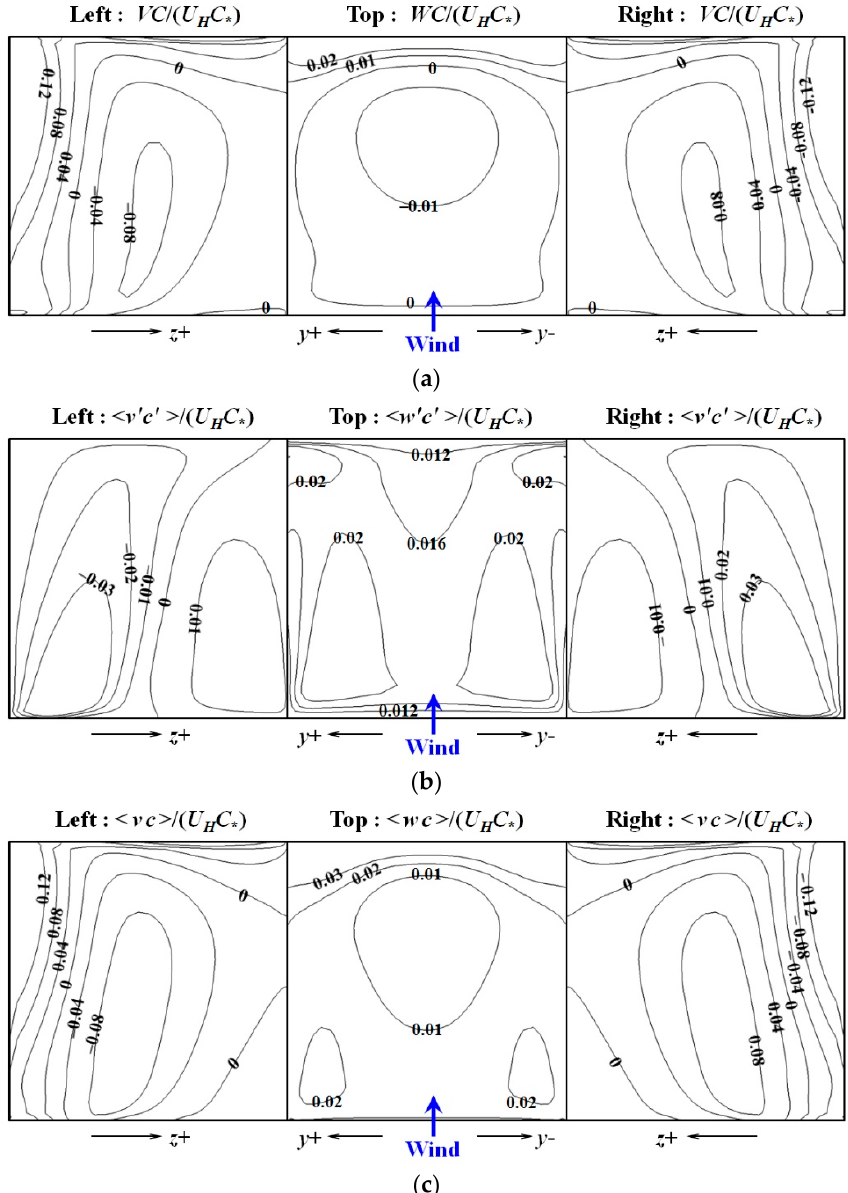
Figure 13. Normalized pollutant fluxes in normal direction at boundaries of the TSC (GH-30): ( a ) convective flux; ( b ) turbulent diffusion flux; ( c ) total pollutant flux.